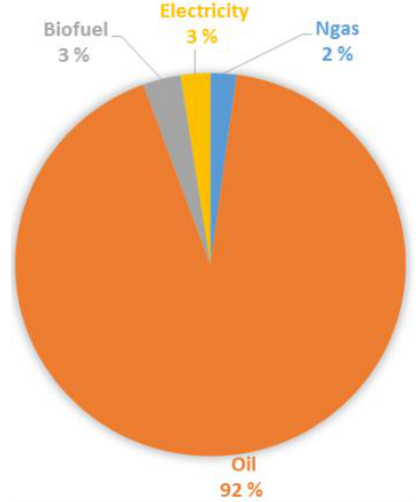
Figure 5. Fuel consumption for transport in Italy.